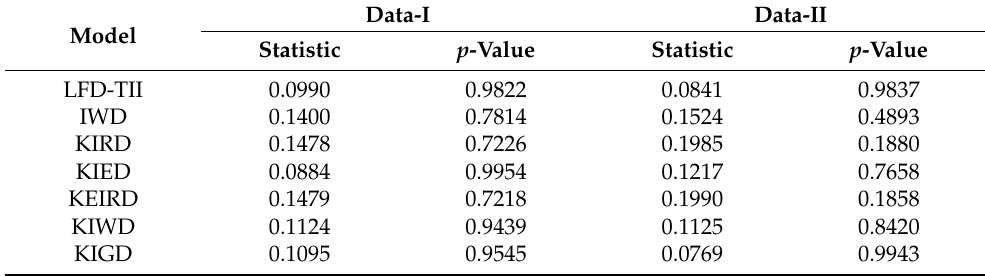
Table 4. K-S results under data sets I and